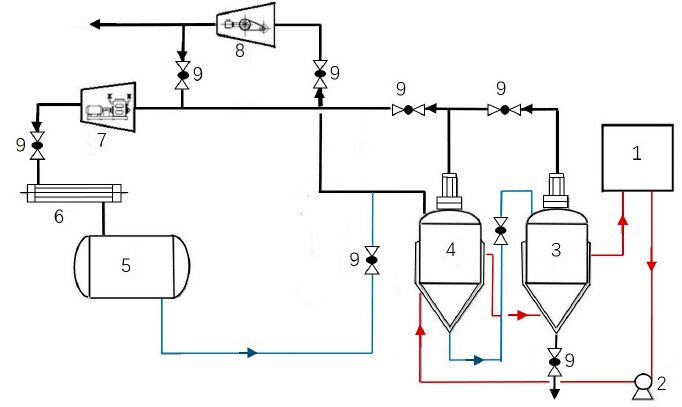
Figure 4. Schematic diagram of the apparatus used in subcritical butane extraction. 1: hot water tank; 2: hot water pump; 3: evaporation tank; 4: extraction tank; 5: solvent tank; 6: condenser; 7: compressor; 8: vacuum pump; 9: spherical